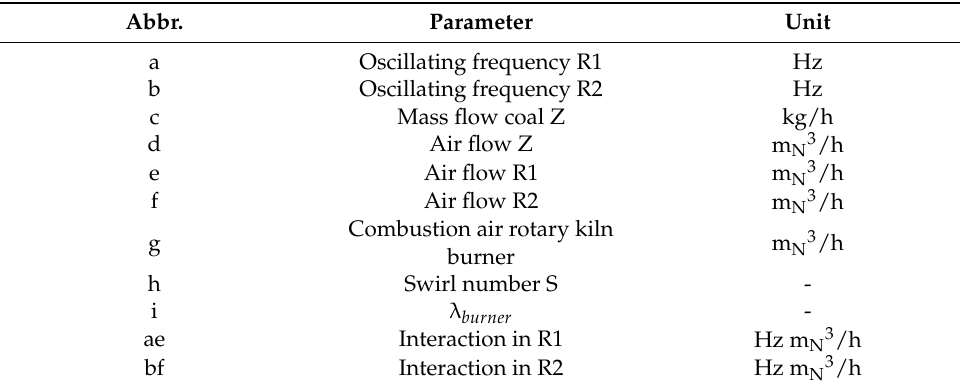
Table 2. Abbreviation of the influencing